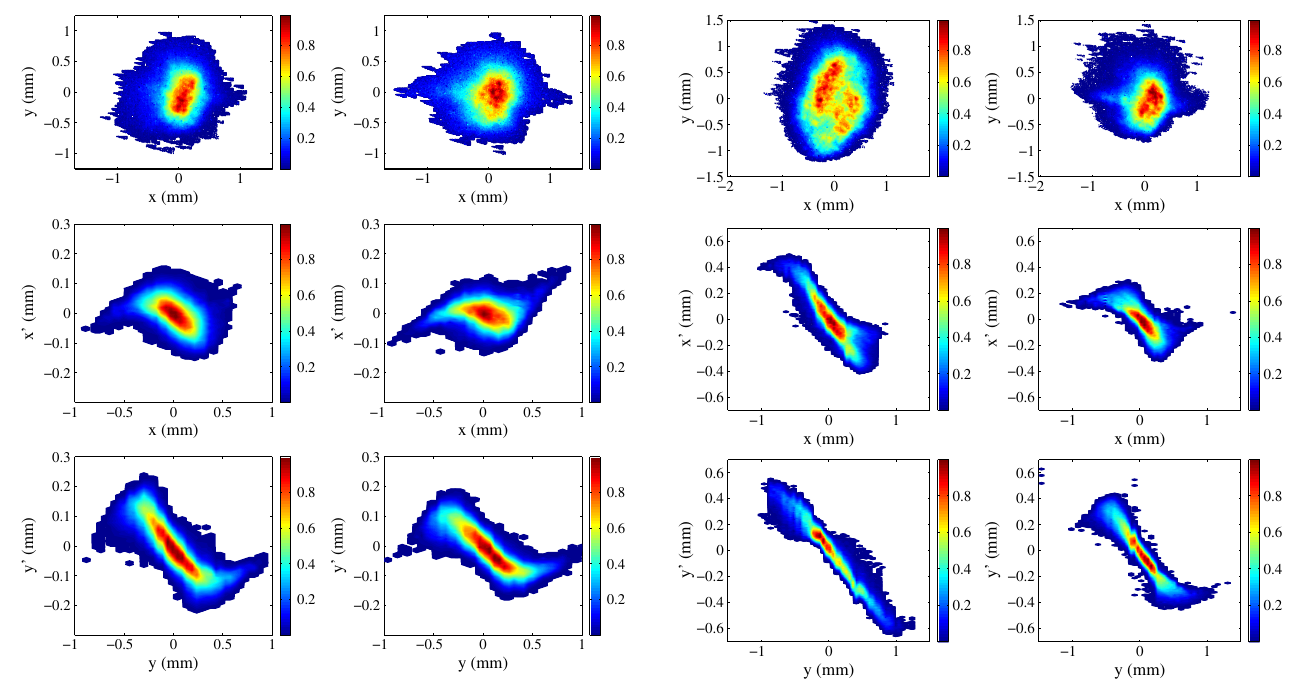
FIG. 22. Measured beam x - y distribution at EMSY1 (upper row), horizontal (middle row), and vertical phase space (bottom row) for a bunch charge of 1 nC. A main solenoid current of 396 A, rf gun phase of þ 6 deg and laser rms spot size of 0.3 mm were applied. The left column of plots corresponds to the measurements with the cathode #110.2, the right column those with the cathode #11.3 (see Table